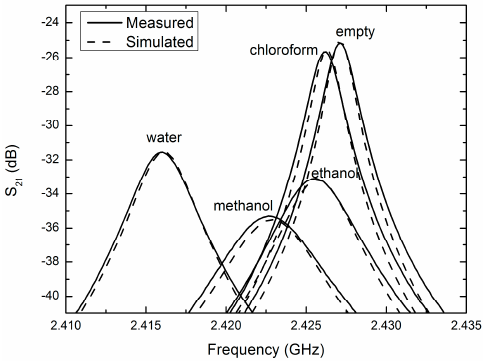
Figure 11. Measured and simulated |S 21 | for several solvents at 25 °C. Table 1. Debye model parameters for liquids at room temperature.